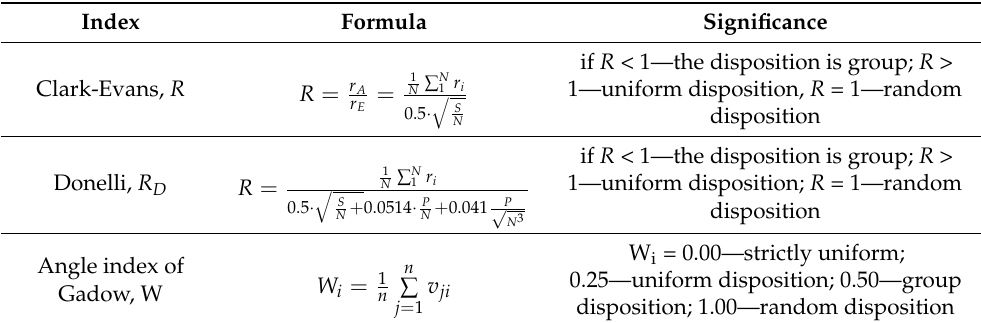
Table 2. Main criteria for estimation of the disposition of